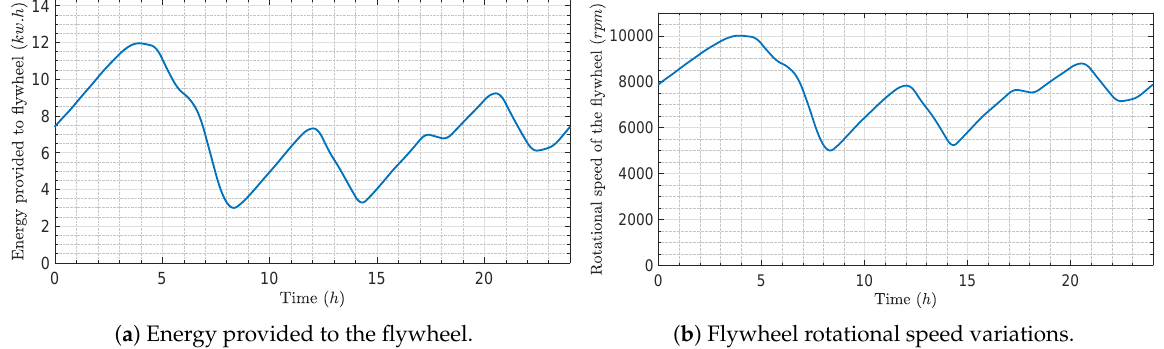
( b ) Flywheel rotational speed variations. Figure 4. Energy and rotational speed of the